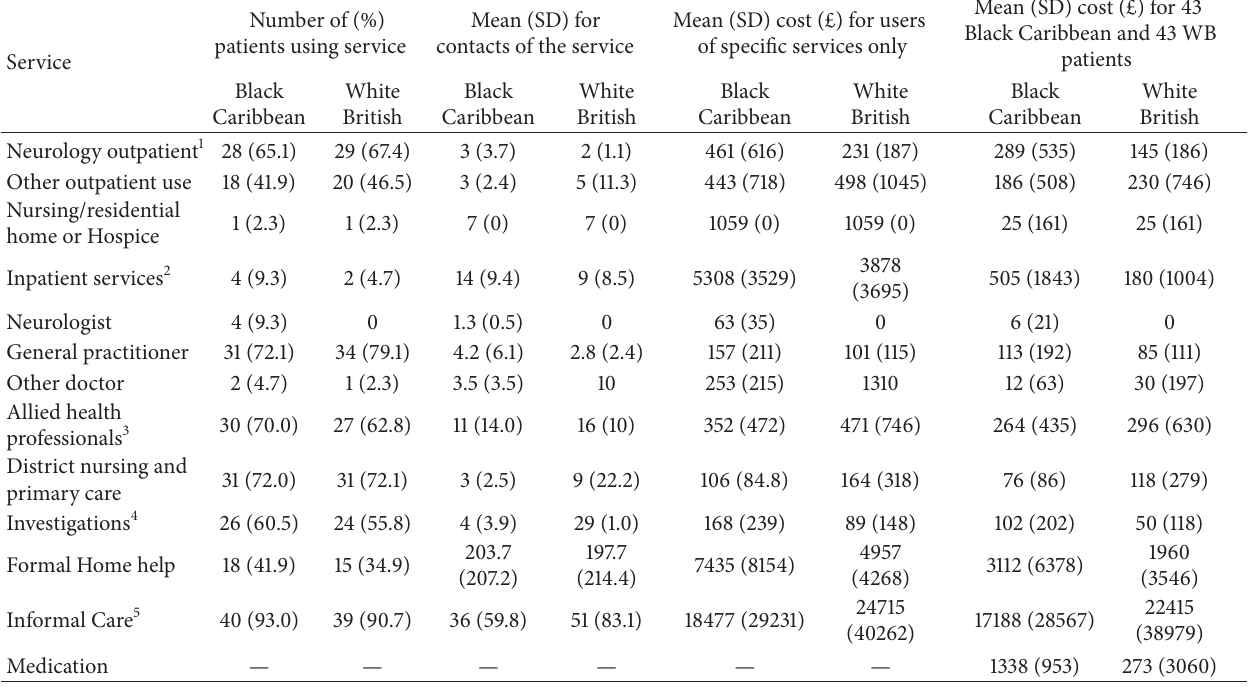
Table 2: Service use and associated cost (£) per 6 months for Black Caribbean and White British